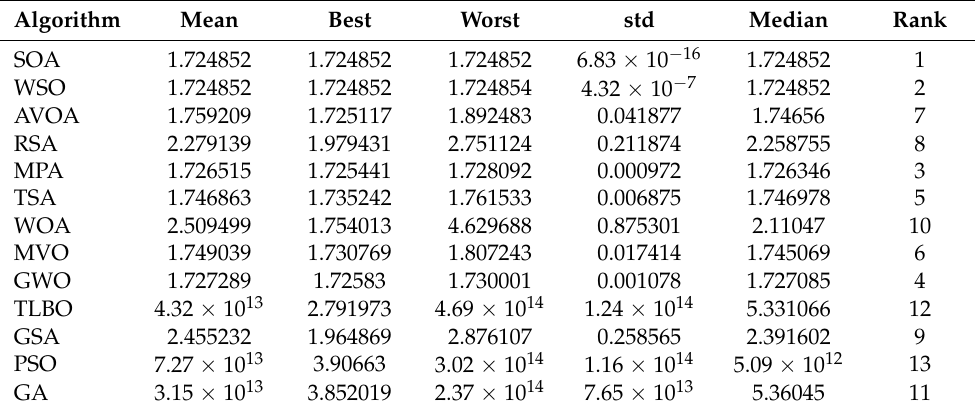
Table 14. Statistical results of optimization algorithms on the welded beam design